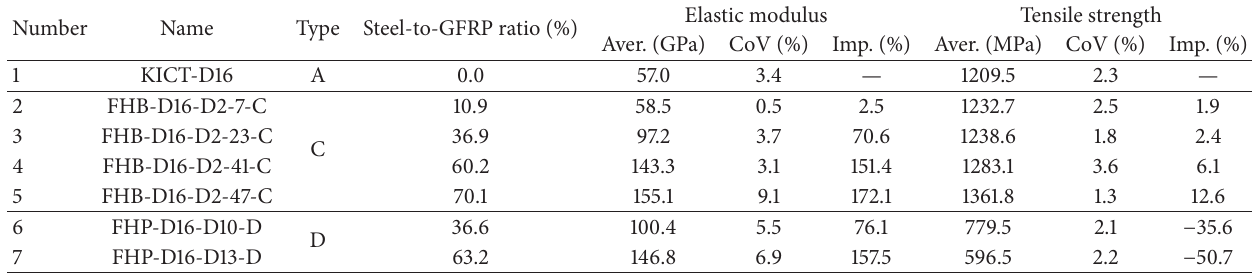
Table 4: Test results for D16 FRP Hybrid Bar.